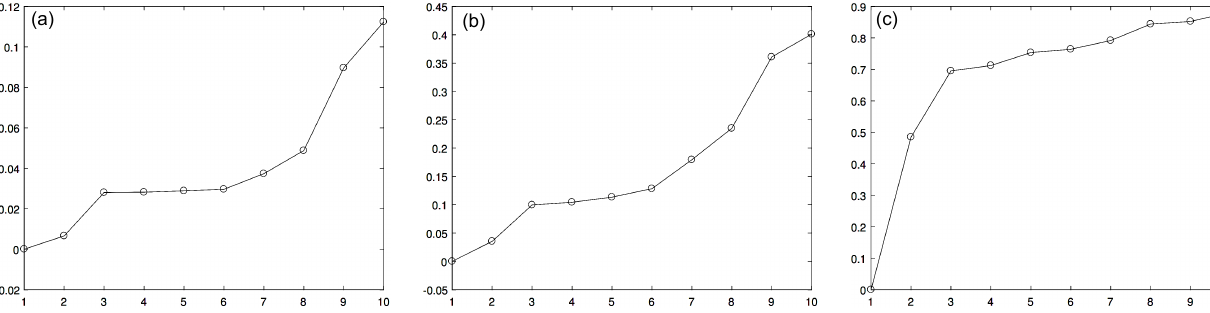
Figure 5. Leading eigenvalues of the generalized graph Laplacian eigenvalue problem Eq. (7) for the Bickley jet. (a) High-resolution data (case i, (cid:15) = 0 . 2); (b) sparse data case ii, (cid:15) = 0 . 5; (c) case ii, (cid:15) = 1 . 9.